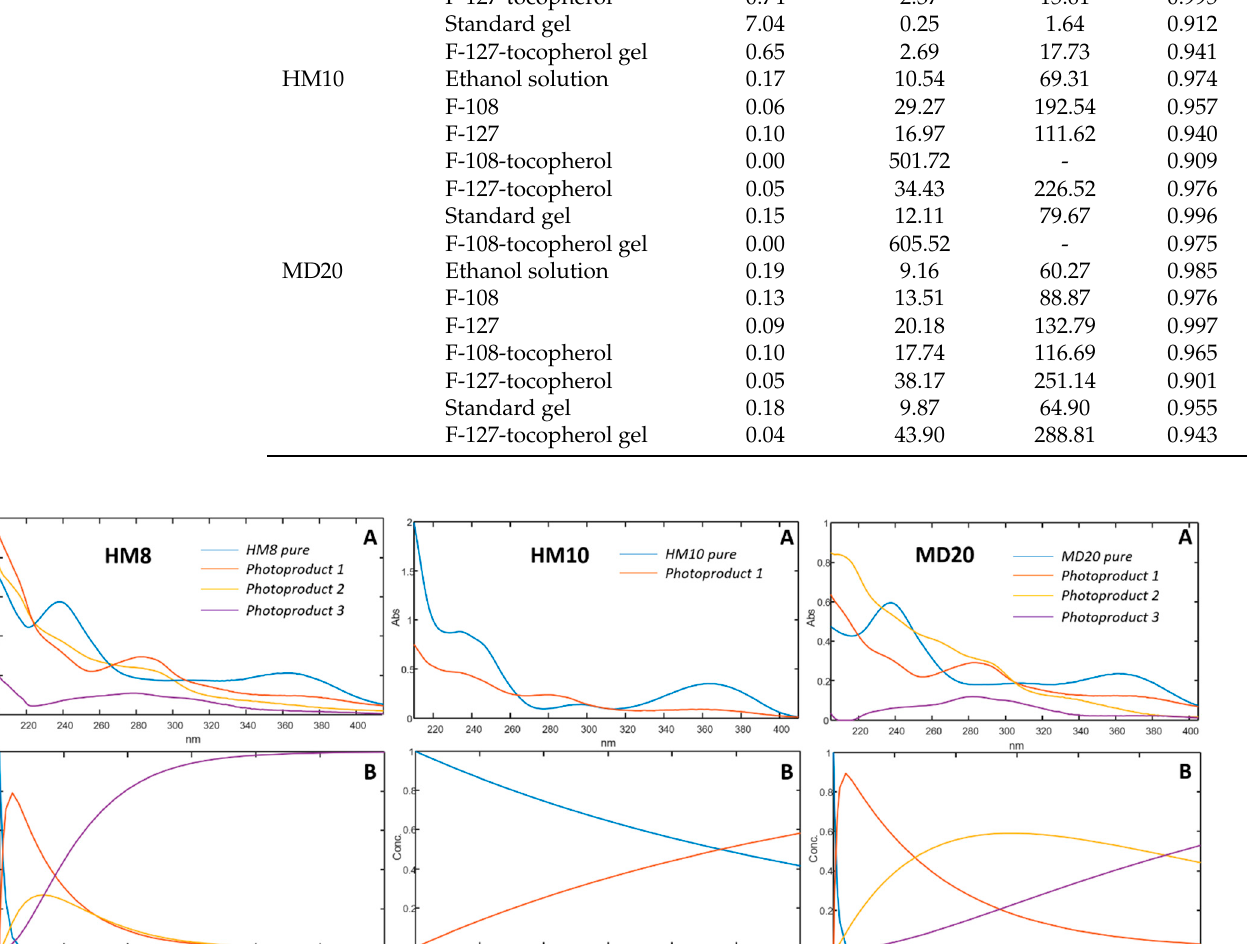
Figure 5. Photodegradation of HM8, HM10 and MD20 in ethanol, surfactant solutions and gel formulations. ES, ethanol solution; T, α -tocopherol. 3.5. Photodegradation of the Gel Formulations The stability of the micellar solutions was also tested in the gel formulation. The mi- cellar systems of the three compounds that showed the best performance, in terms of en- trapping percentage and photostability, were formulated in gel, as above described. The photodegradation profiles of these formulations were compared with those of a standard